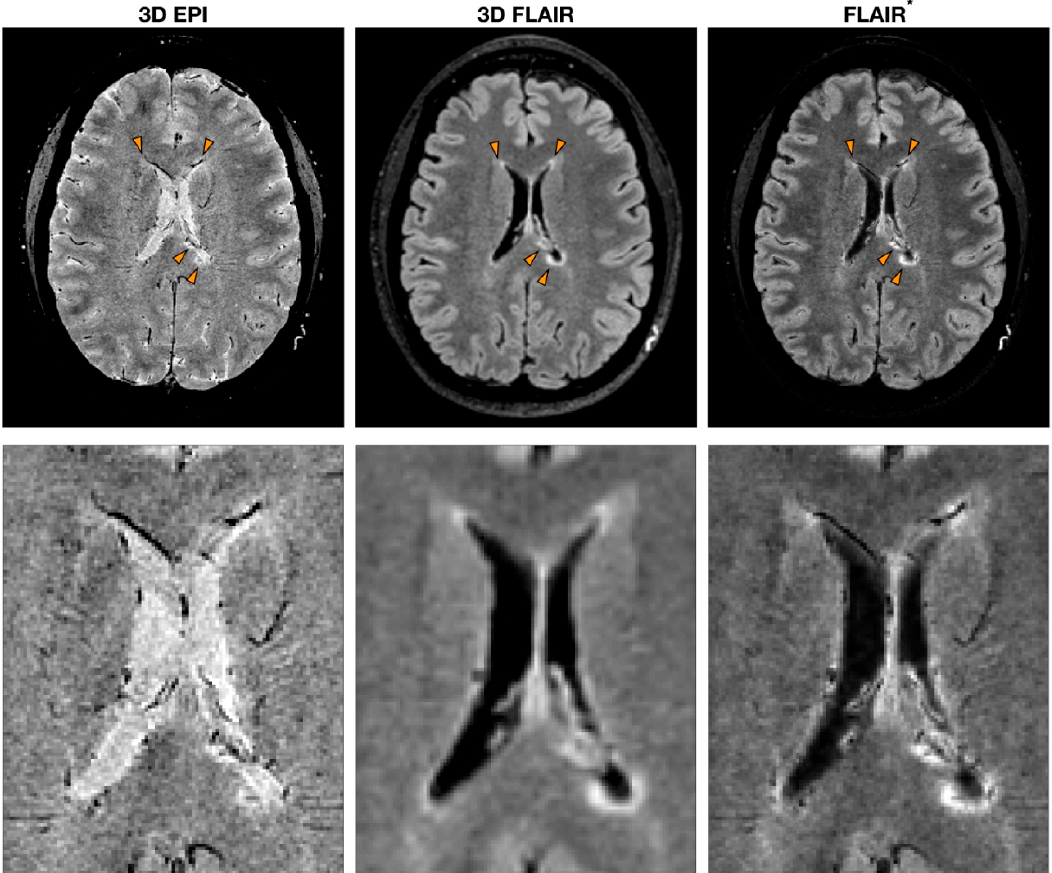
Figure 1. Example of multiple sclerosis (MS) patient MRI images obtained with sequences to detect the central vein sign (CVS). T2*-weighted 3D echo-planar imaging (EPI), 3D fluid-attenuated inversion recovery (FLAIR) and FLAIR*, a post-processing technique that combines the EPI sequence [or more generally a T2*w sequence (used to detect CVS)] and FLAIR. The orange arrowheads indicate MS lesions with the characteristic CVS. A zoomed-in version of the same image is reported to highlight the CVS feature for each modality.